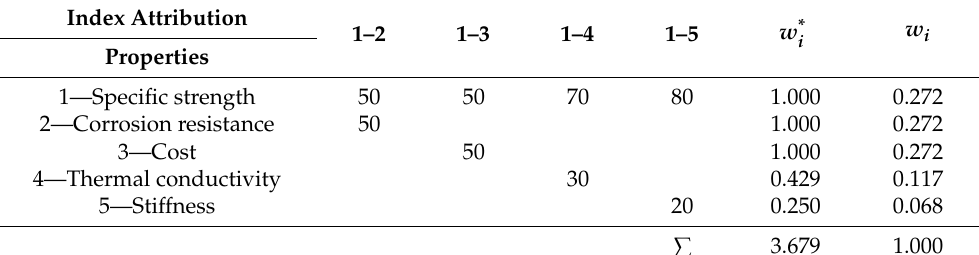
Table 5. Properties index weight attribution for the lid.